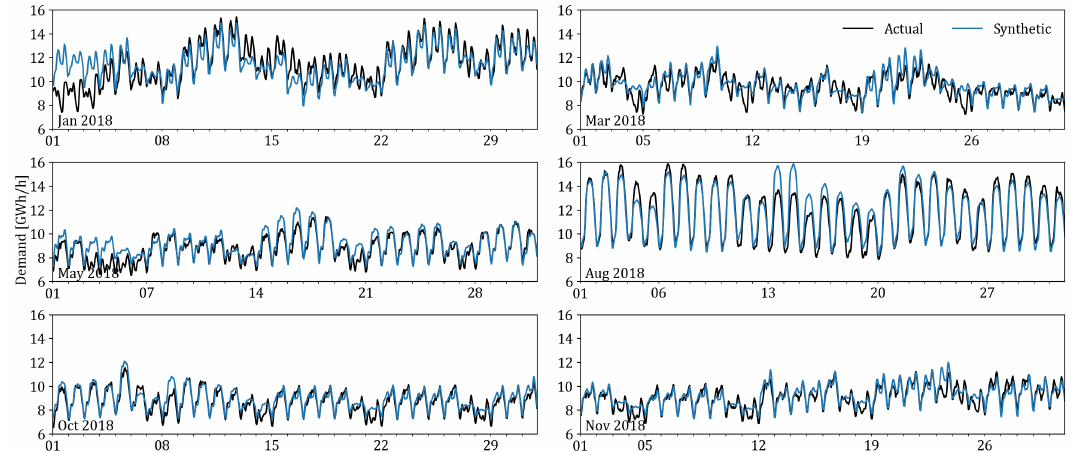
Figure 7. Sample demand synthesis for 2018.